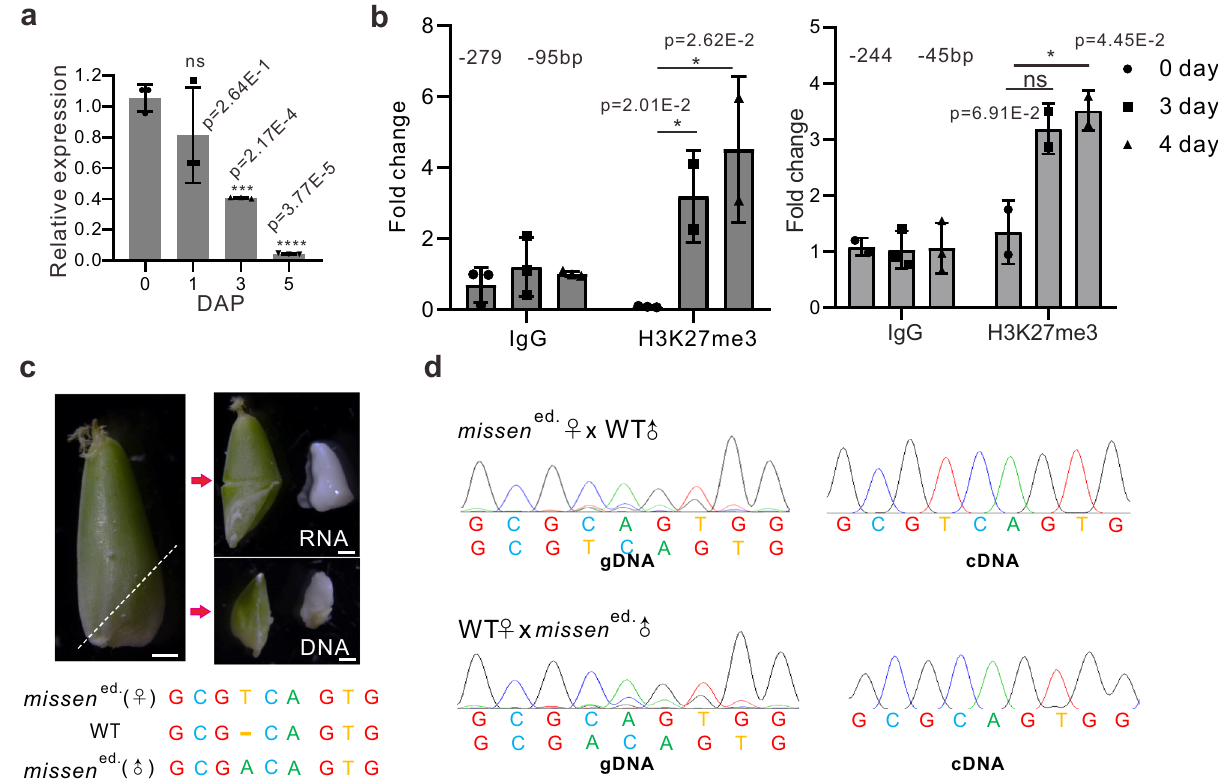
Fig. 7 Parent-of-origin analysis of the lncRNA MISSEN . a The expression pattern of MISSEN in developing WT caryopses. Values are the means ± SD ( n = 3 replicates, normalized against ACTIN2 ). b ChIP analysis of the H3K27me3 modi fi cations in the promoter region of MISSEN . Values are the means ± SD ( n = 3 replicates, normalized against IgG). c Schematic diagram of endosperm separation. Scale bars, 1 mm. d The genotypes and expressed MISSEN transcripts in endosperm of the hybrid offspring of MISSEN ed. transgenic plants with WT plants. Signi fi cant differences were identi fi ed at the 5% (*), 1% (**), 0.1% (***) and <0.01% (****) probability levels using two-tailed paired t -test.